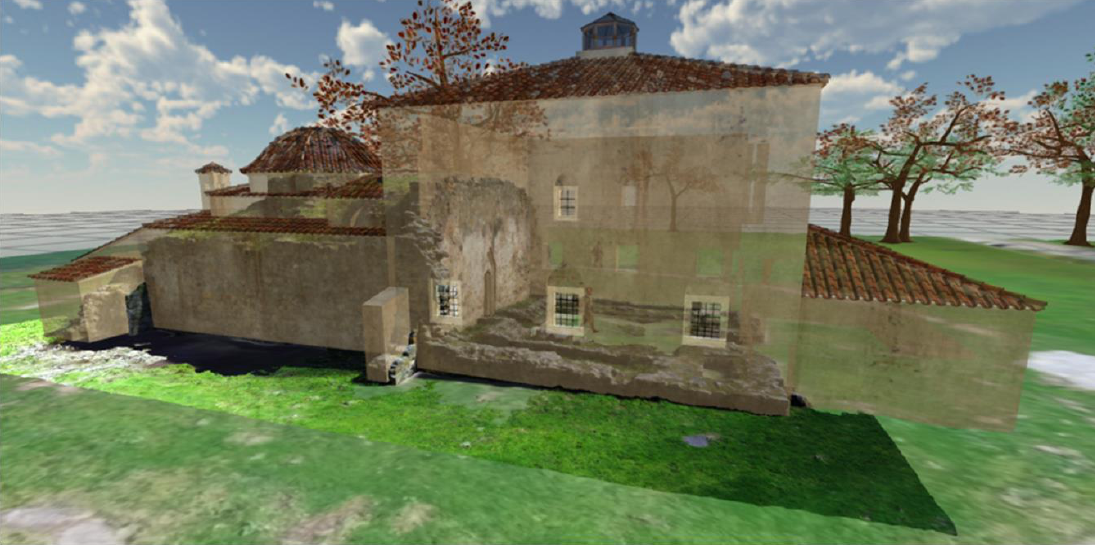
Figure 11. The “Mergin’ Mode” end user app providing the reconstructed Ottoman bath merged with its current state in a mergin’